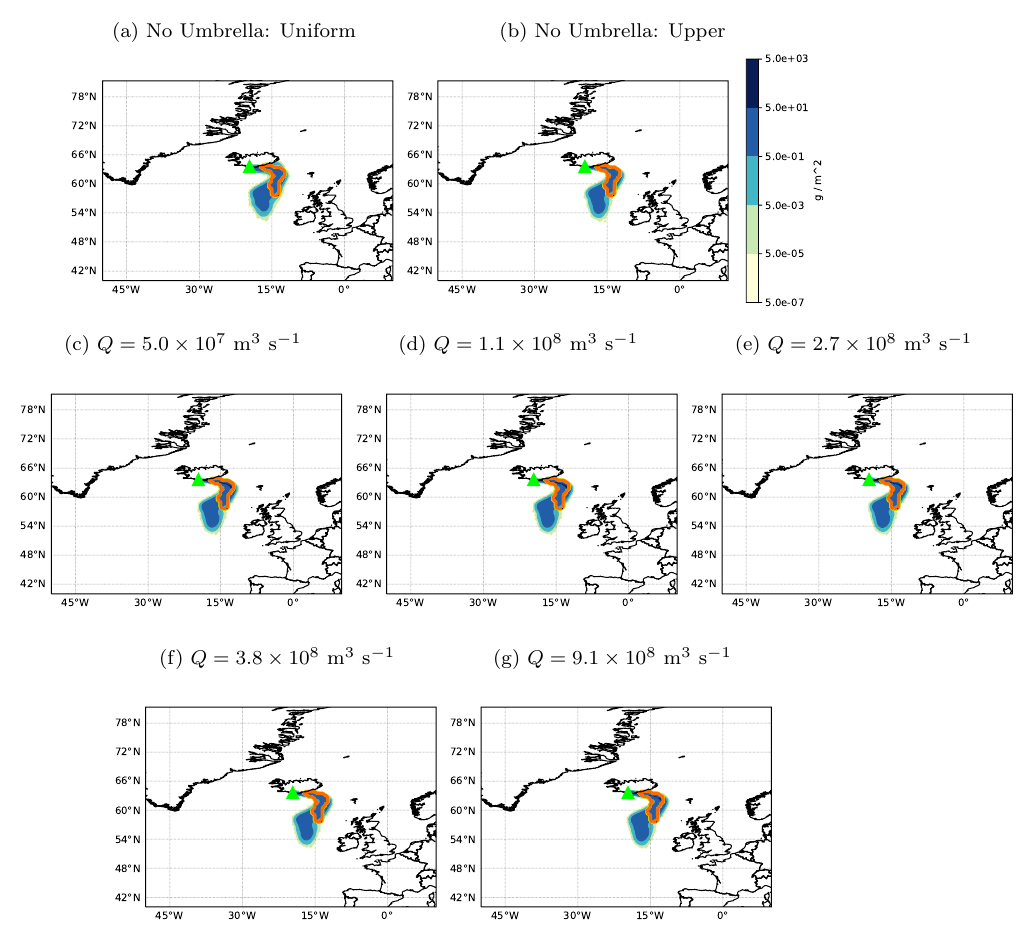
Figure 4. Modelled (filled contours in g m − 2 ) and SEVIRI satellite observations (orange open contour corresponding to ash retrievals of 0.5 g m − 2 ) of the Eyjafjallajökull ash cloud at 13:00 UTC on 6 May 2010. Model simulations in ( a , b ) do not use the umbrella cloud parameterisation and are described in Section 5. Simulations in ( c – g ) use the umbrella parameterisation with different estimates of the volume flow rate, Q . The volcano location is marked by a green